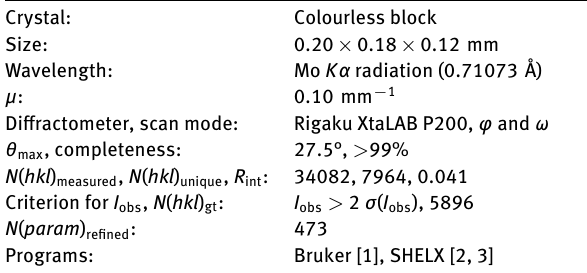
Table 1: Data collection and